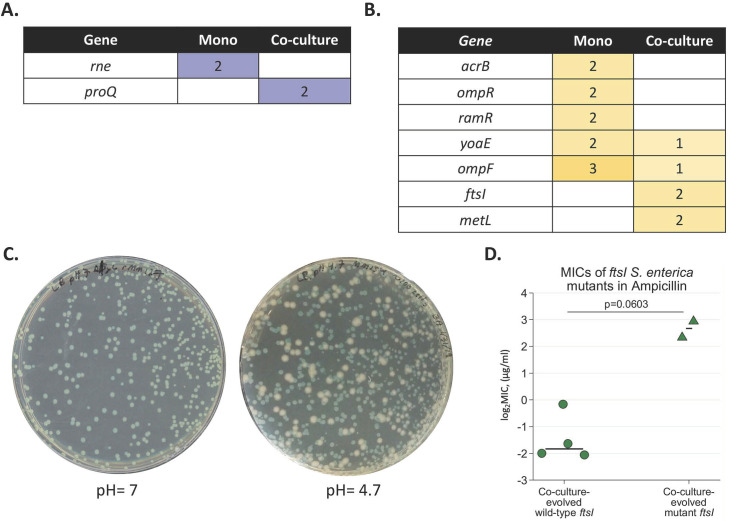
Resistance- associated mutations in ampicillin-resistant evolved populations A-B. Lists of mutations which arose in E. coli (A) or S. enterica (B) monocultures and co-cultures. The number in each box represents the number of independent replicates in which the putative resistance mutation was observed. Additional mutations that occurred in only one population, and details on the nature of these mutations, may be found in S1 Table. C. Image of co-culture populations containing ftsI mutations on Petri plates with LB pH = 7 (left) and pH = 4.7 (right). Blue colonies are E. coli which metabolize X-gal to a blue color; white colonies are S. enterica. No white colonies were observed on LB at pH = 7. D. MICs of isolates from libraries containing ftsI mutations in pH = 4.7 medium. Isolates were obtained from passage 10 populations by streaking onto selective medium and picking isolated colonies. Each data point represents the average MIC of three isolates from a single population. For each species- culture type combination, there are six populations total, and the statistical comparisons represent MIC comparisons between populations with wild type vs. mutant alleles MIC90 values for isolates were defined as the lowest concentration of antibiotic which decreased growth by greater than 90% by 48 hours at 30°C. Each point represents the average MIC of three isolates from a single population. P = 0.0603, Mann-Whitney U.